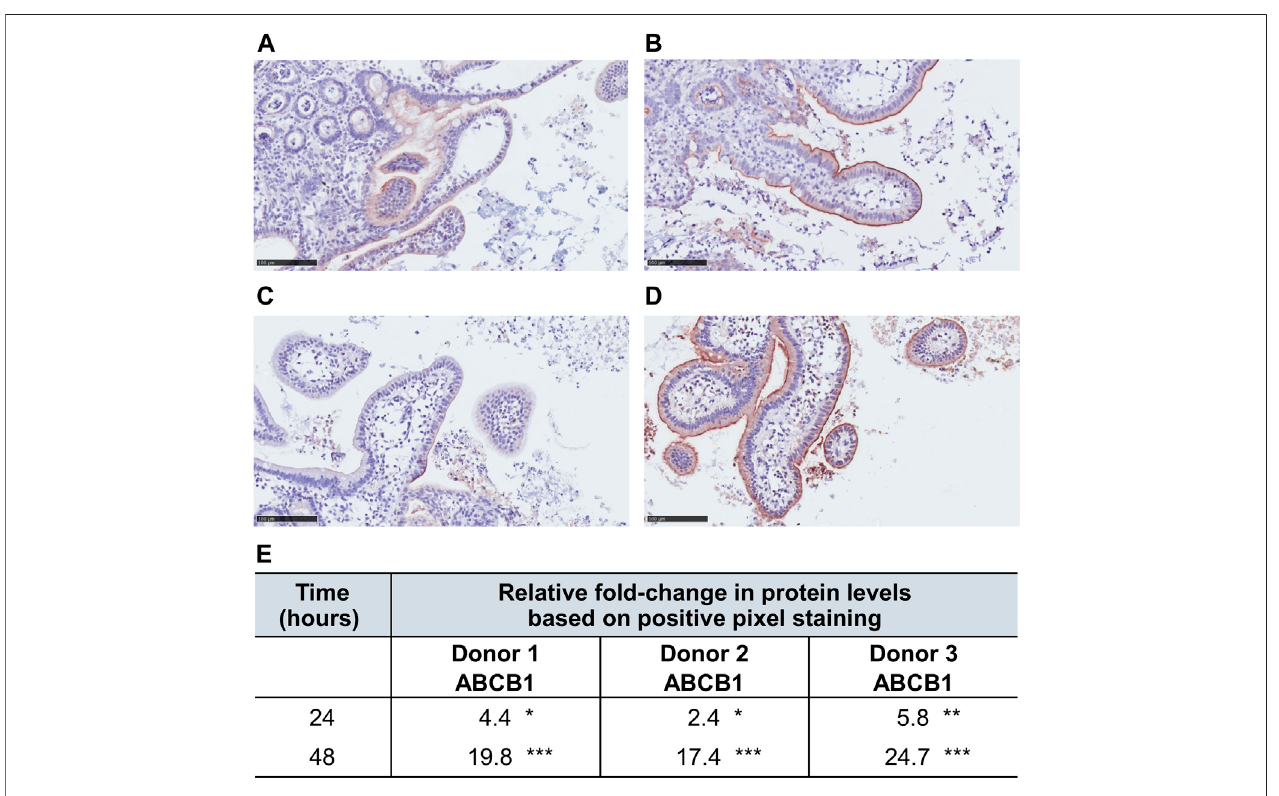
FIGURE5| ABCB1levels(indicatedbybrownstaining)inRIF-freesamplesincubatedfor24 h (A) and48 h (C) andincounterpartstreatedwith30 µMRIFfor24 h (B) and48 h (D) .Theslideswerecounterstainedwithhematoxylin(scalebar (cid:2) 100 µm).Panels (A – D) representonlyapartialcutoutofthewholesectiontodemonstrate immunohistochemicalstaining.Imagesoftheentiresectionswereusedfortheanalysis. (E) FoldchangesinnumbersofstrongABCB1-positivepixelsbetweenimagesof RIF-treated and RIF-free hPCISs from donors after incubation for indicated times according to subsequent algorithmic analysis. Asterisks indicate signi fi cant differences between them according to one-sample t -tests ( n (cid:2) 3): *, p < 0.05; **, p < 0.01; ***, p < 0.001.